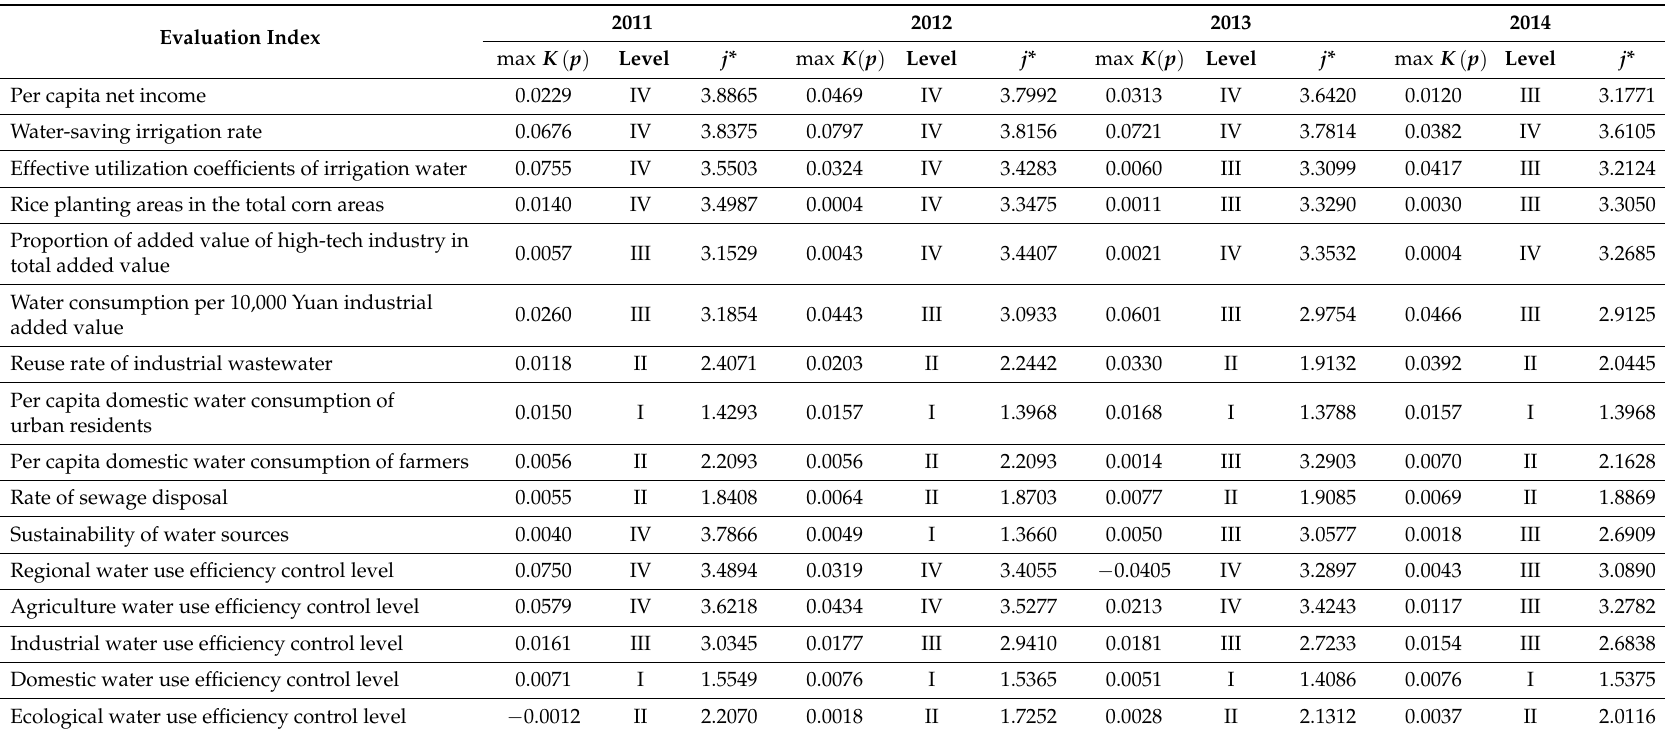
Table 9. Evaluation results of water use efficiency control in Jiangxi Province during